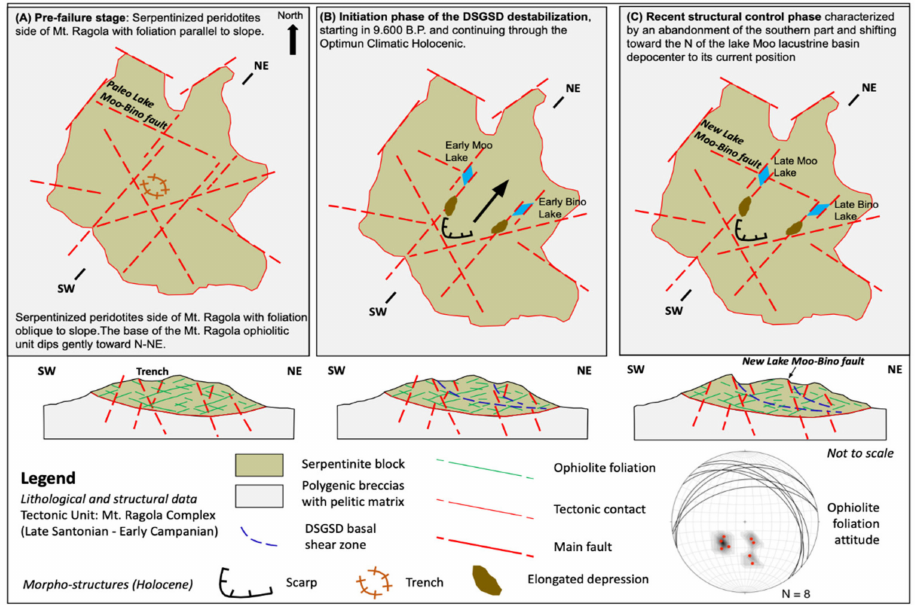
Figure 11. Synthetic conceptual model showing the origin and subsequent evolution of the Moo and Bino lakes. ( A ) Pre-failure stage: Serpentinized peridotites side of Mt. Ragola with foliation parallel to slope; ( B ) Initiation phase of the DSGSD destabilization, starting in 9.600 B.P. and continuing through the Holocene Climatic Optimum; ( C ) Recent structural control phase characterized by an abandonment of the southern part and shifting toward the N of the lake Moo lacustrine basin depocenter to its current